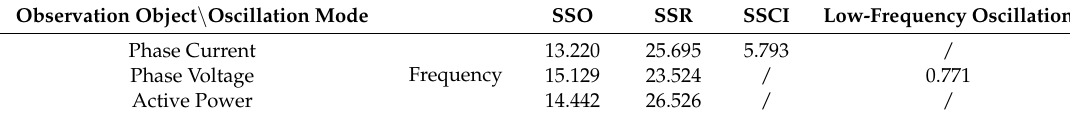
Table 6. Analysis of Oscillation Mode of Wind Turbine on Forecasted Phase Current, Phase voltage and Power.